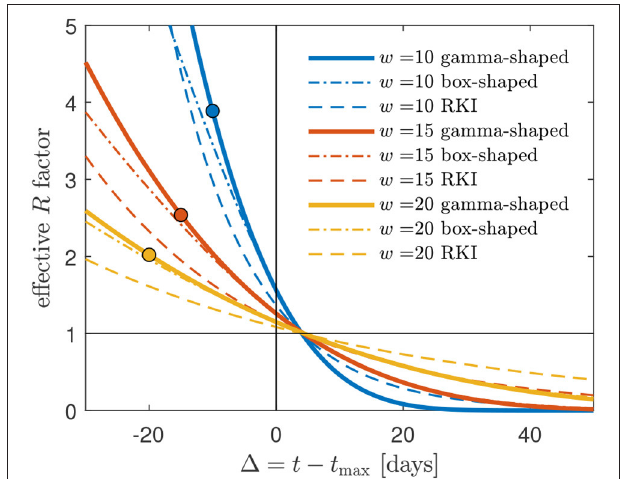
R ( t 0 ) for the GM as function of FIGURE 4 | Basic reproduction number R 0 = peak width w for several peak heights c max (thick solid lines). For comparison, the thin lines show the approximant (34). The exact R 0 is given by (33) √ ln c max . x 0 evaluated at x = =